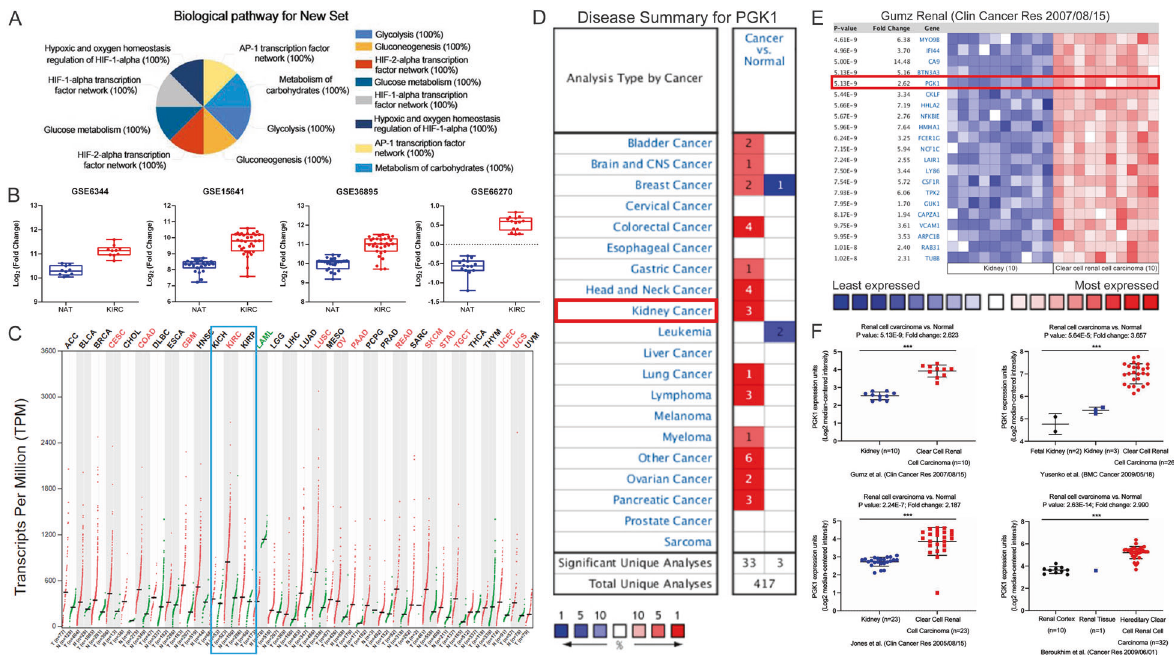
Fig. 2 PGK1 is speci fi cally upregulated in KIRC subtype of RCC. A PGK1-mediated biological pathways analyzed by FunRich software. B The expression levels of PGK1 gene were compared between KIRC tissues and NATs from online 4 datasets (GSE6344, GSE15641, GSE36895, and GSE66270). C PGK1 gene expression pro fi le across all tumor samples and paired normal tissues from online GEPIA database. Each dot represented expression of a sample. D Expression pattern of PGK1 gene in multiple human malignancies assayed from the Oncomine database. The number in the colored cell represented the cases that satis fi ed the thresholds. The more intense red (overexpression) or blue (underexpression) suggested a more highly signi fi cant upregulated or downregulated gene. E The fold changes of mRNA levels of PGK1 in KIRC tissues compared with NATs from the Oncomine dataset (Gumz renal). F PGK1 gene was con fi rmed to signi fi cantly upregulate in KIRC from Oncomine database dissection. Oncomine datasets include 4 subtypes, including 1, Gumz renal; 2, Yusenko renal; 3, Jones renal; and 4.